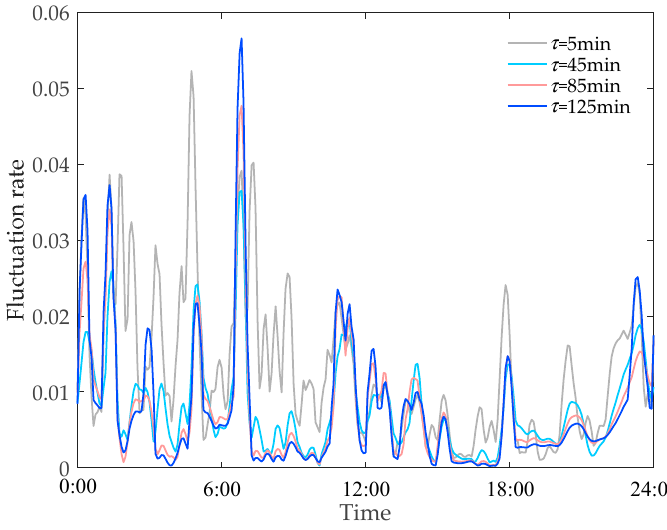
Figure 12. Total load power fluctuation rate under different filter time constants. Table 1. Simulation results under di ff erent filter time